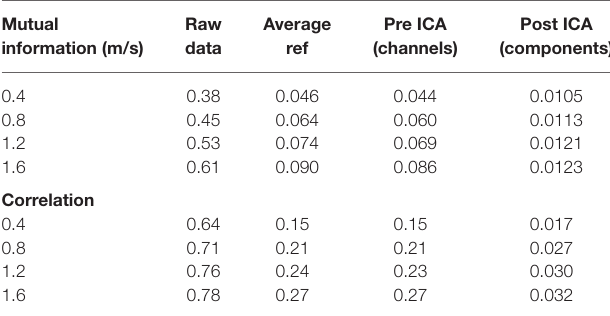
TABLE 1 | Mutual information and correlation at various stages of analysis for the artifact data for individual speeds. Mutual